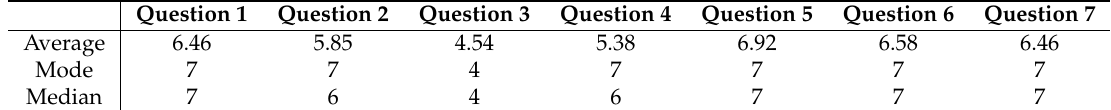
Table 5. Results obtained through the course feedback survey.